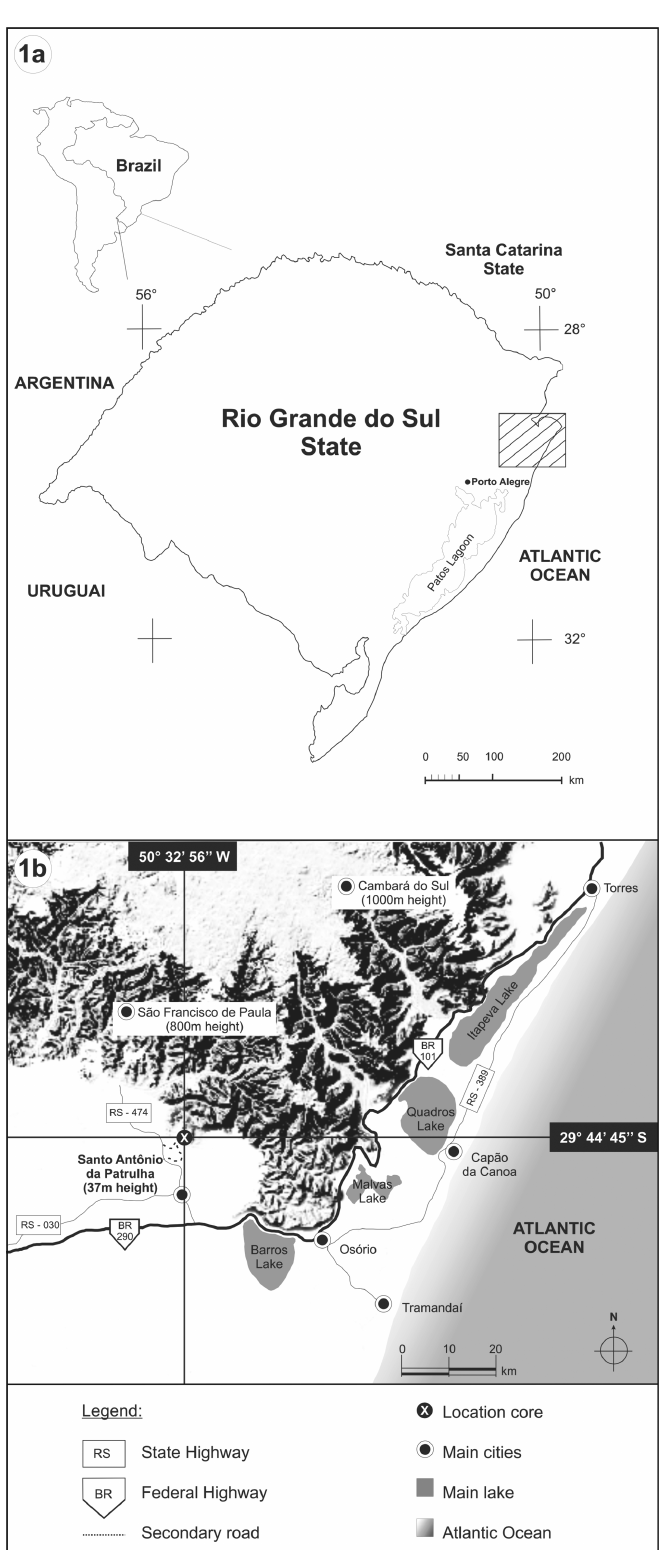
Fig. 1 – Location map showing the general situation (a) and position of the Santo Antônio da Patrulha core (b)